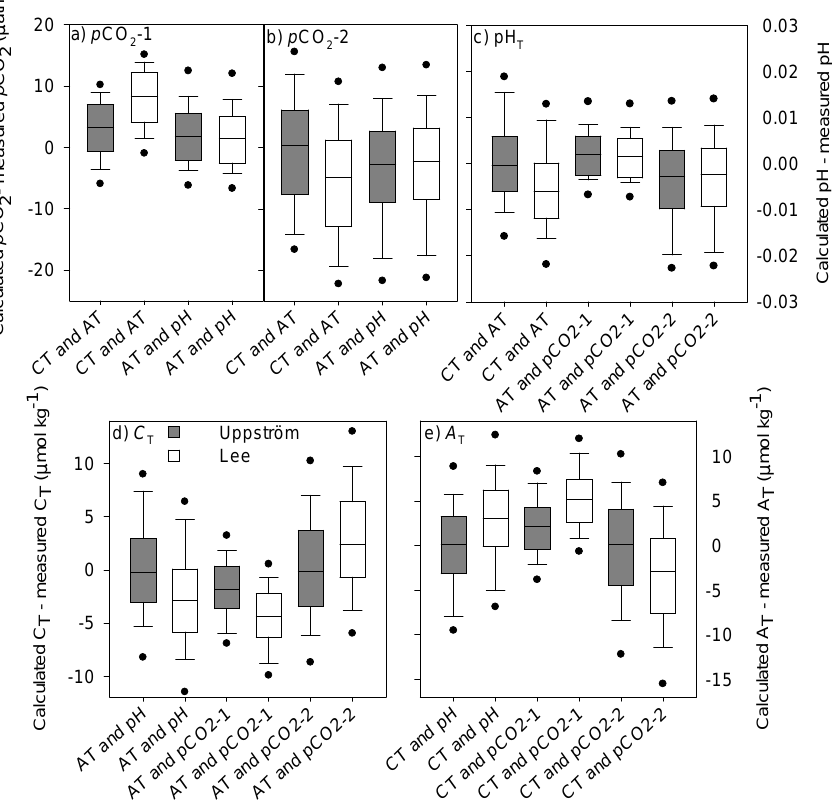
Figure 6. Box-and-whisker plots of the residuals between measured p CO 2 -1 (a) , p CO 2 -2 (b) , pH T (c) , C T (d) , A T (e) and the respective estimates calculated from different pairs of measured variables (denoted on the x axis) for the two sets of ratios of total boron to salinity. Grey plots depict the distributions of residuals using the constants of Uppström (1974), and white plots denote those using Lee et al. (2010). The boxes show the median and the 25th and 75th percentiles; dots are the 5th and 95th percentiles. Table 2 presents the RMSE and MR.